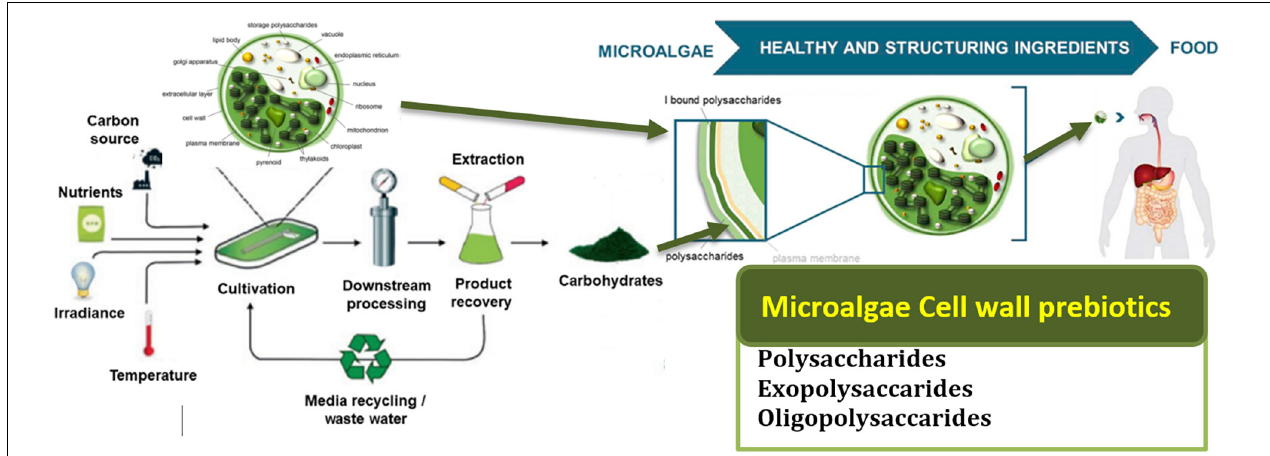
Protein Carbohydrate (%) oil (%) (%) include prebiotics